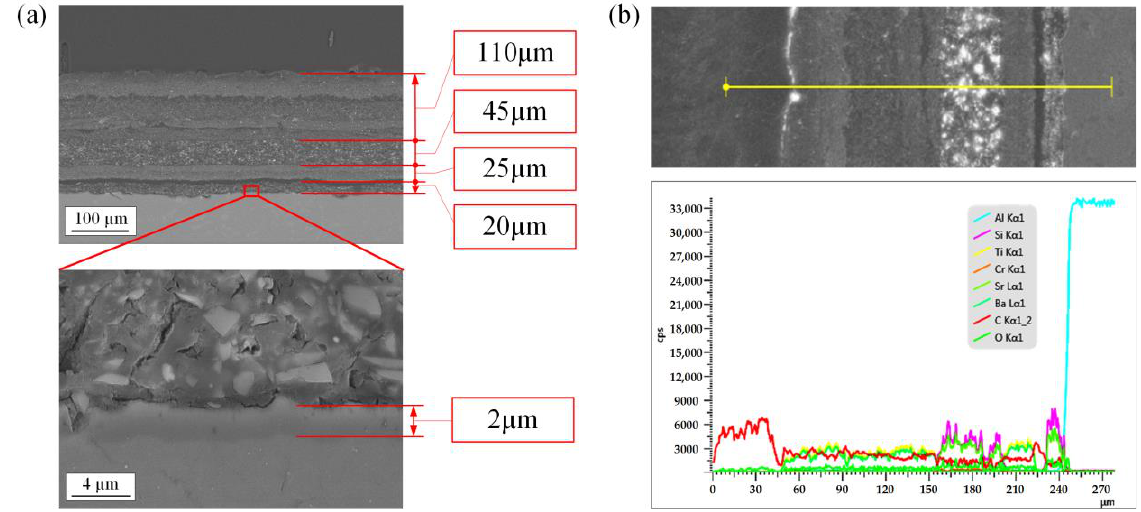
Figure 1. Structure of Boeing aircraft skin: ( a ) cross-section observation of the skin, ( b ) EDS analysis of the skin cross-section.